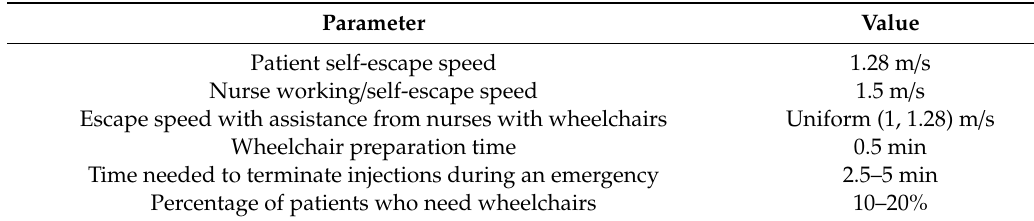
Table 4. Simulation parameters for evacuation